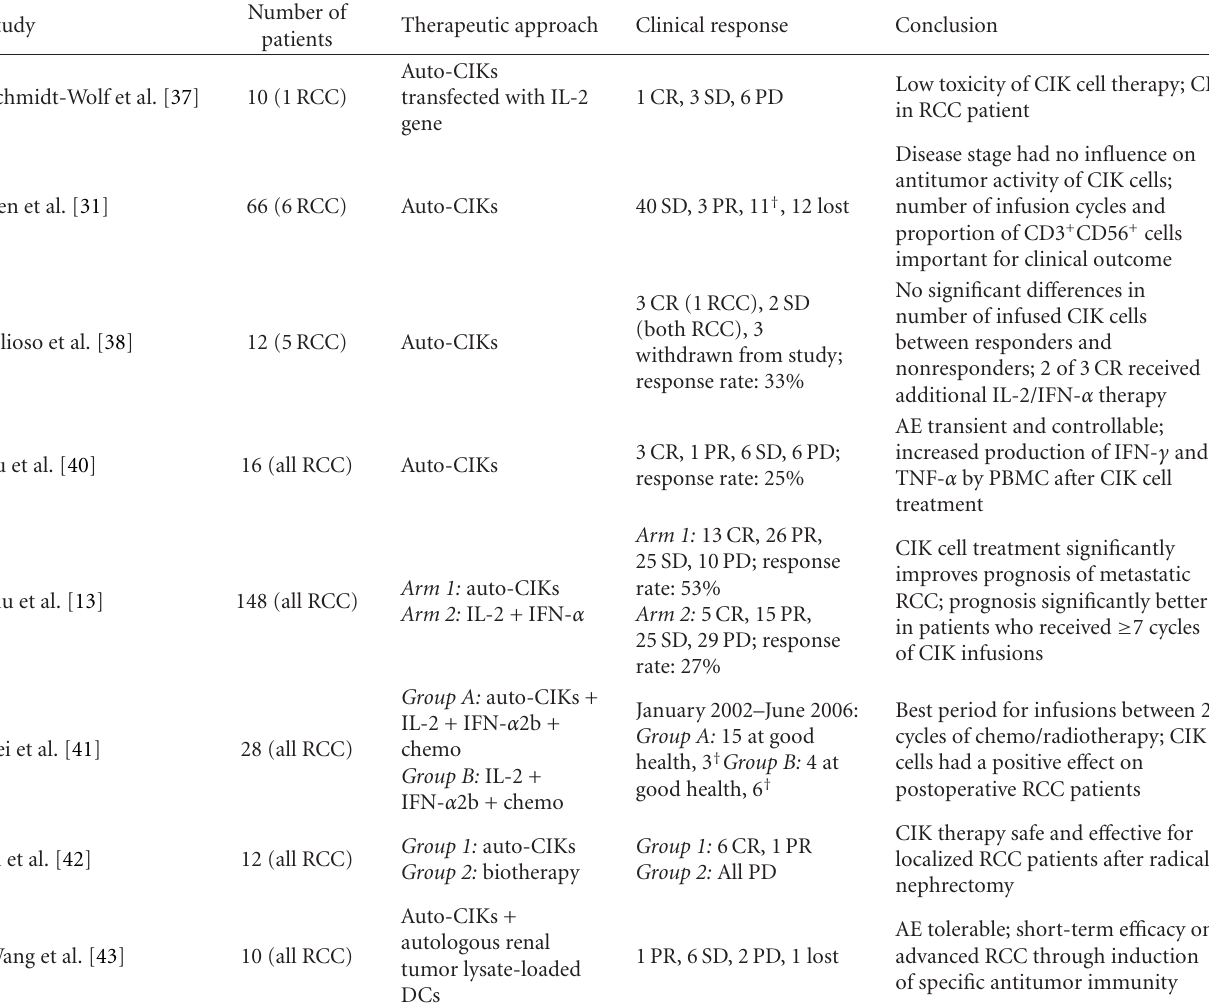
Table 2: Clinical studies applying CIK cells for the treatment of